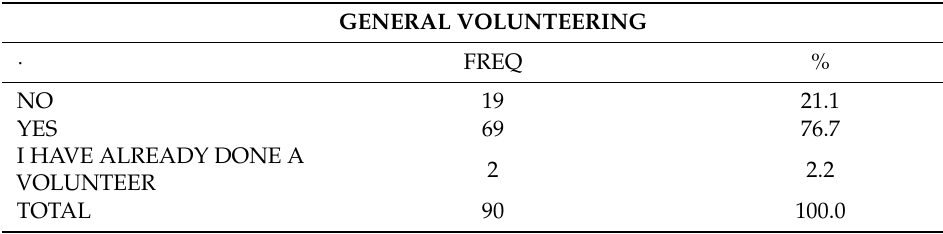
Table 3. Answers about general volunteering.